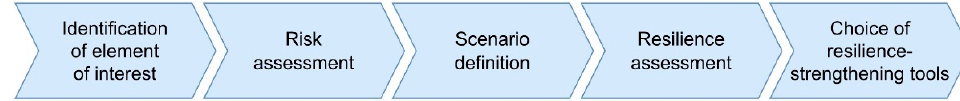
Figure 2. Procedure for strengthening the resilience of energy critical infrastructure elements.